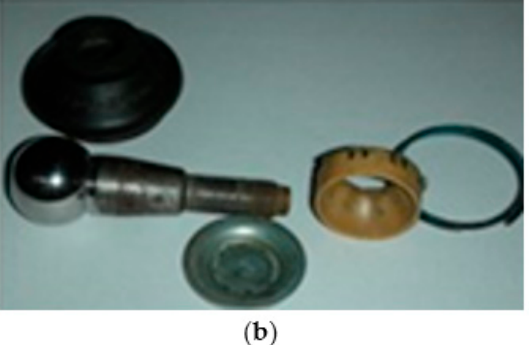
Figure 3. ( a ) New ball joint; ( b ) Disassembled used ball joint.